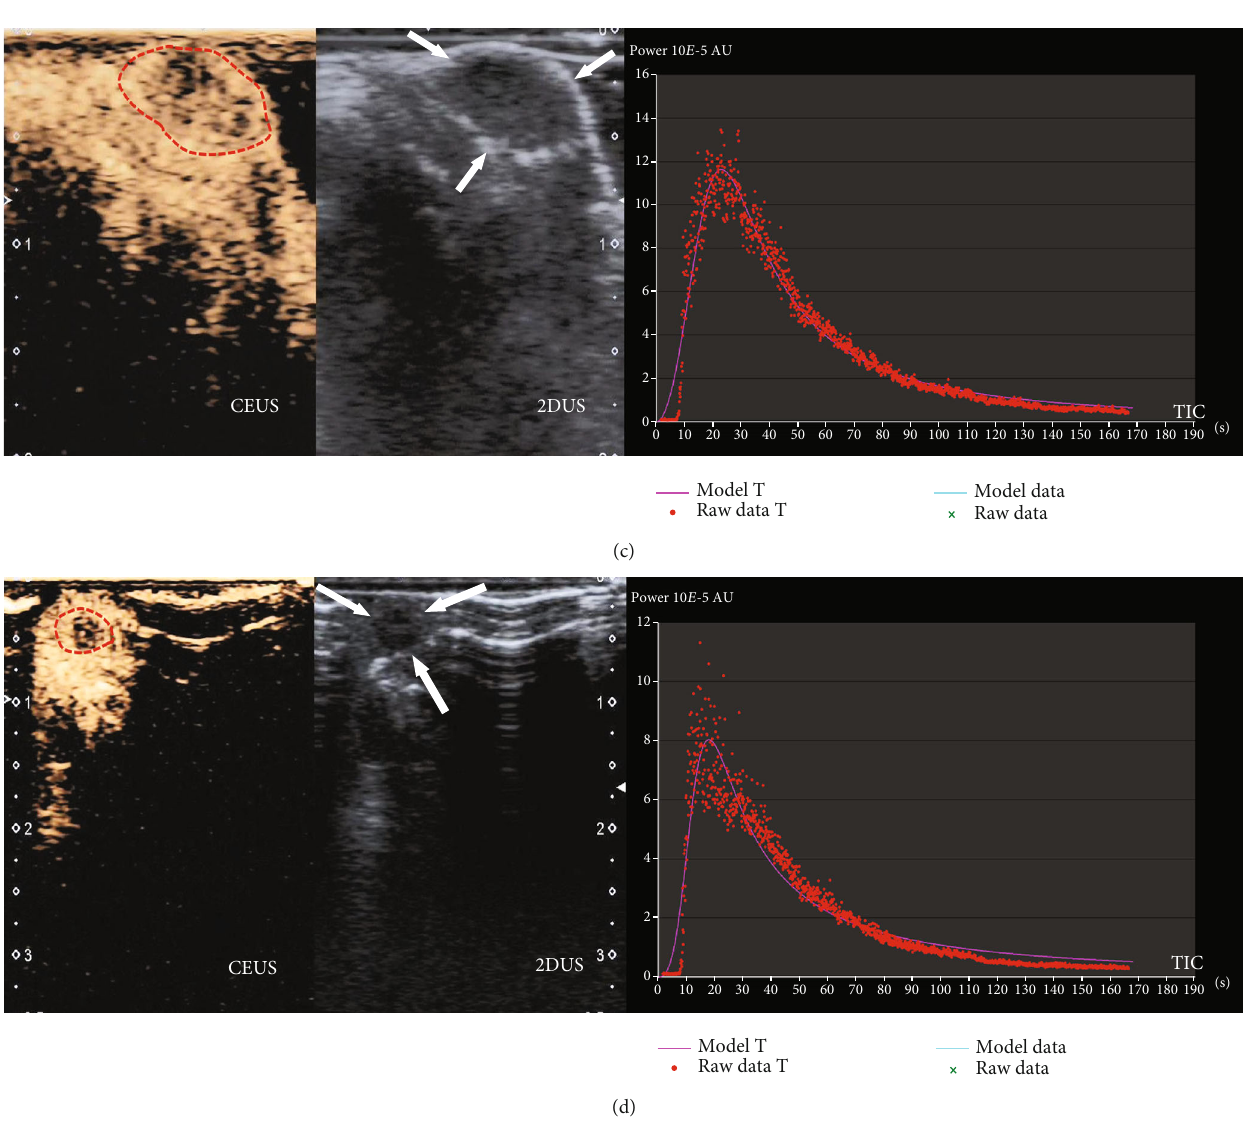
Figure 3: Tumors in di ff erent groups on CEUS. (a) An intense enhancement was shown in the tumor on CEUS (red circle) in the M group, and the tumor was heterogeneous hypoechoic on 2DUS and sized 10 : 8mm × 10 : 0mm × 9 : 8 mm (white arrow), with the PI of 25.1 (10 E -5 AU) and the AUC of 858.9 (10 E -5 AU · s) on TIC. (b) A heterogeneous enhancement with spotty fi lling defect was shown in the tumor on CEUS (red circle) in the UTMD group, and the tumor was heterogeneous hypoechoic on 2DUS and sized 11 : 2 mm × 10 : 9mm × 6 : 6 mm (white arrow), with the PI of 22.5 (10 E -5 AU) and the AUC of 724.3 (10 E -5AU · s) on TIC. (c) The heterogeneous enhancement with patchy fi lling defect was noted in the tumor on CEUS (red circle) in the APA group, and the tumor was homogeneous hypoechoic on 2DUS and sized 8 : 1mm × 5 : 5mm × 7 : 7mm (white arrow), with the PI value of 11.6 (10 E -5 AU) and the AUC of 589.9 (10 E -5 AU · s) on TIC. (d) The heterogeneous enhancement with patchy fi lling defect and homogeneous hypoechoicity was observed in the tumor on CEUS (red circle) in the APA-U group, and the tumor had homogeneous hypoechoicity on 2DUS and a small size ( 6 : 9mm × 6 : 0mm × 5 : 1 mm ; white arrow), with the PI of 8.0 (10 E -5AU) and the AUC of 372.1 (10 E -5 AU · s) on